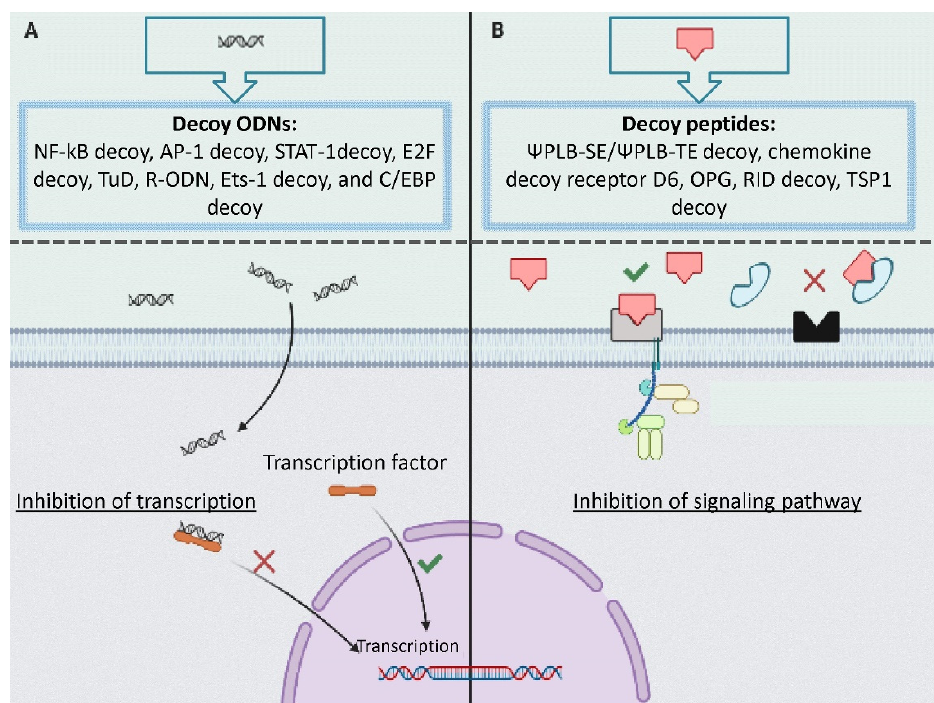
Figure 2. The mechanism of action of decoys: ( A ) decoy oligodeoxynucleotides (ODN) including NF-kB decoy, AP-1 decoy, STAT-1decoy, E2F decoy, tough decoy, R-ODN, and C/EBP decoy inhibits transcription by binding to the transcriptional factor; ( B ) decoy peptide including Ψ PLB-SE/ Ψ PLB-TE decoy, chemokine decoy receptor D, decoy receptor osteoprotegerin neutralizes receptors by binding to the ligands.